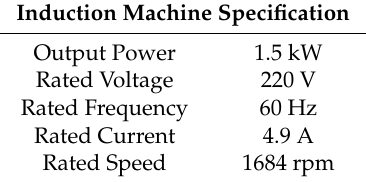
Table 2. Induction Machine Specification.